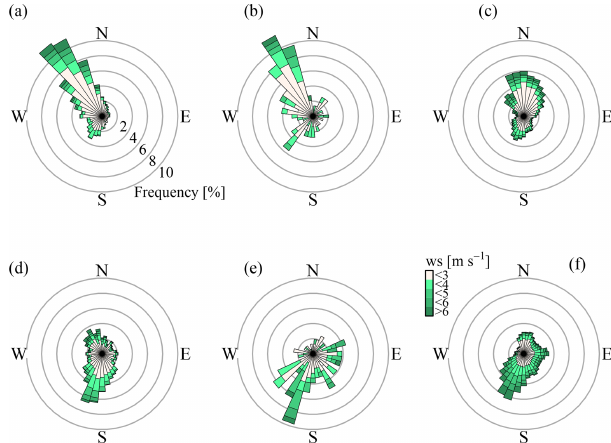
Figure 4. Beijing wind roses: (a, b, d, e) ERA-Interim 10m hori- zontal wind (40 ◦ N, 116.5 ◦ E) and (c, f) sonic anemometer (Table